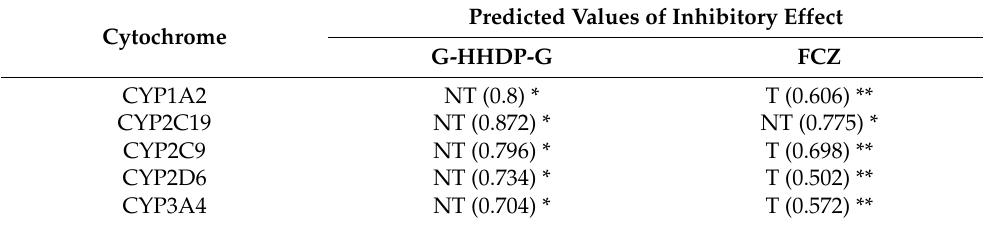
Table 3. In silico prediction of chemical toxicity in hepatic cytochromes.